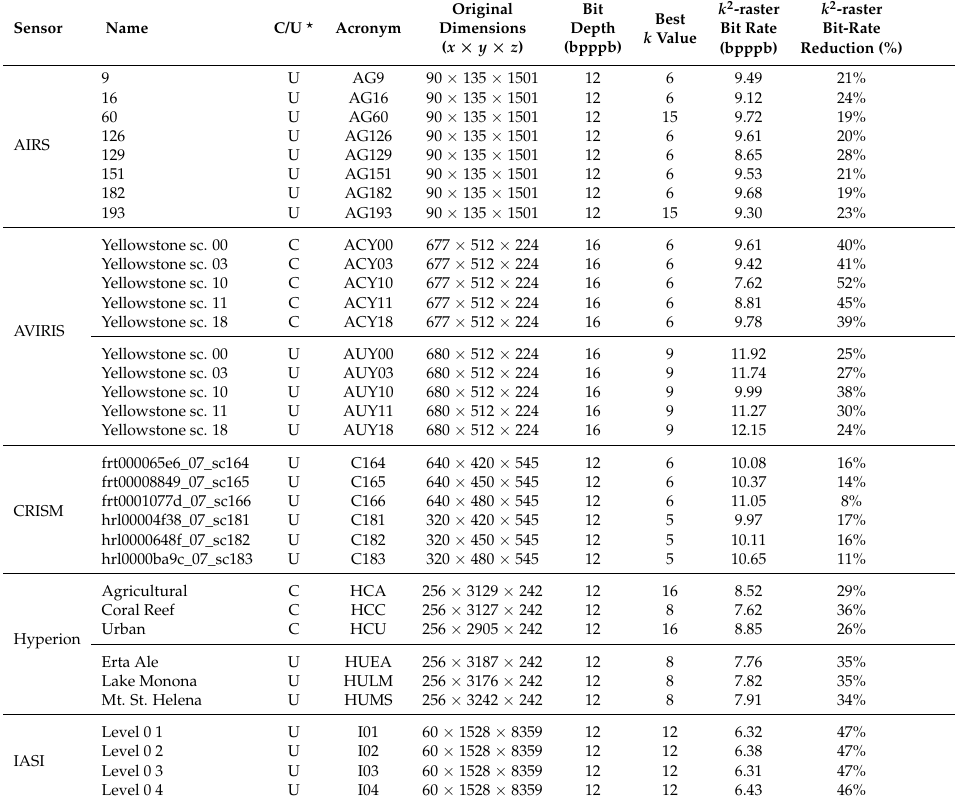
Table 8. Hyperspectral scenes used in our experiments. Also shown are the bit rate and bit rate reduction using k 2 -raster. x is the scene width, y the scene height, and z the number of spectral bands. bpppb, bits per pixel per band; CRISM, Compact Reconnaissance Imaging Spectrometer for Mars; IASI, Infrared Atmospheric Sounding